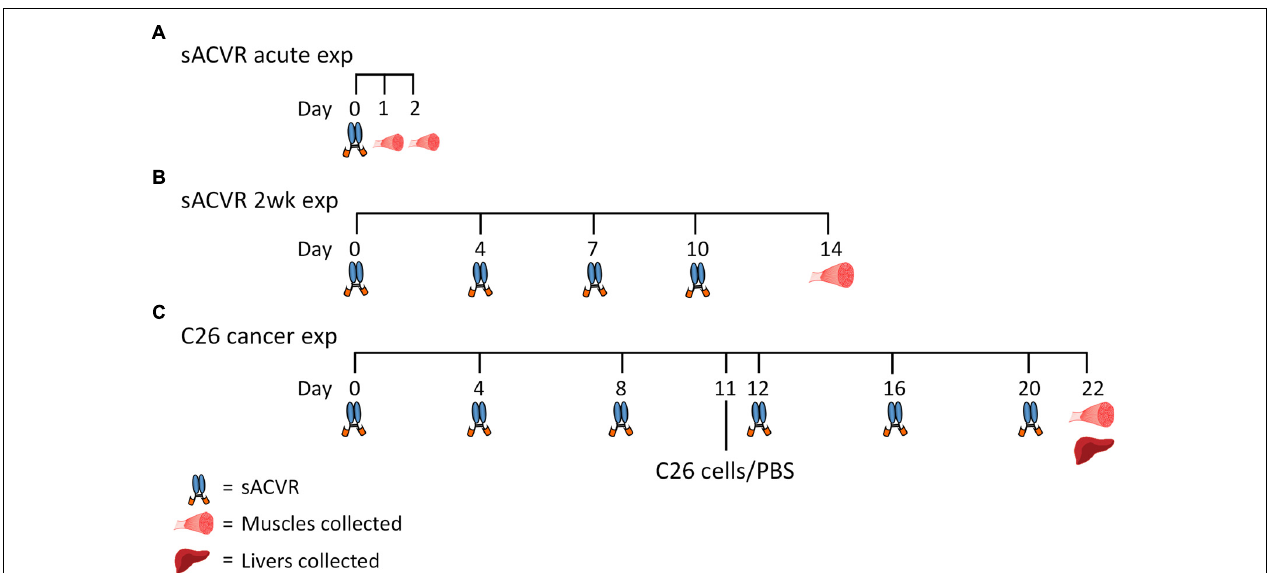
FIGURE 1 | Overall study design. (A) Healthy mice were administered (i.p.) with a single dose of vehicle (PBS) or soluble activin receptor type 2B (sACVR) to block ACVR2B ligands. Muscles were collected either 1 or 2 days after the single sACVR or vehicle administration ( n = 6–7 per group). (B) Healthy mice were administered (i.p.) with vehicle (PBS) or sACVR for 2 weeks (1–2 times per week) and muscles were collected ( n = 6 in PBS and n = 11 in sACVR 2wk). (C) C26 cancer experiment: (1) CTRL (+PBS, n = 9), (2) C26 + PBS ( n = 7), (3) C26 + sACVR/b ( n = 7), and (4) C26 + sACVR/c ( n = 8). Cancer groups were inoculated subcutaneously (s.c.) with C26 cells on day 11. The vehicle (PBS) and sACVR2B-Fc were administered (i.p.) every fourth day. Muscles and livers were collected 11 days after the C26 cell